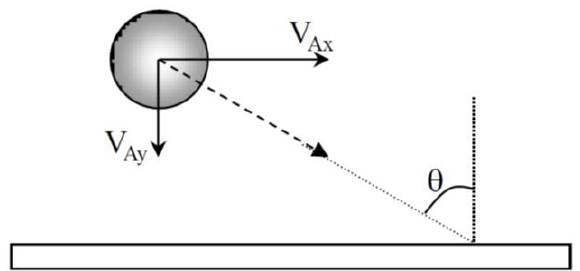
Figure 8. Approach angle of a particle near the electrode.